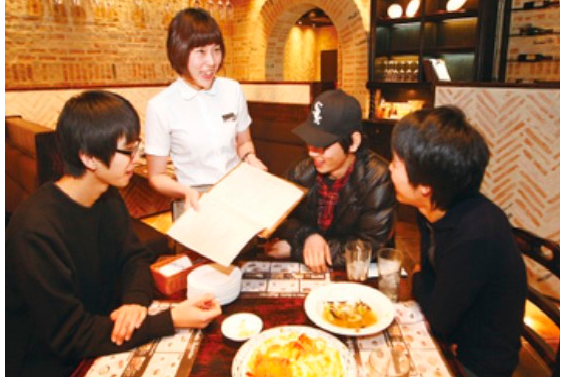
Figure A1. A restaurant where humans provide the services.